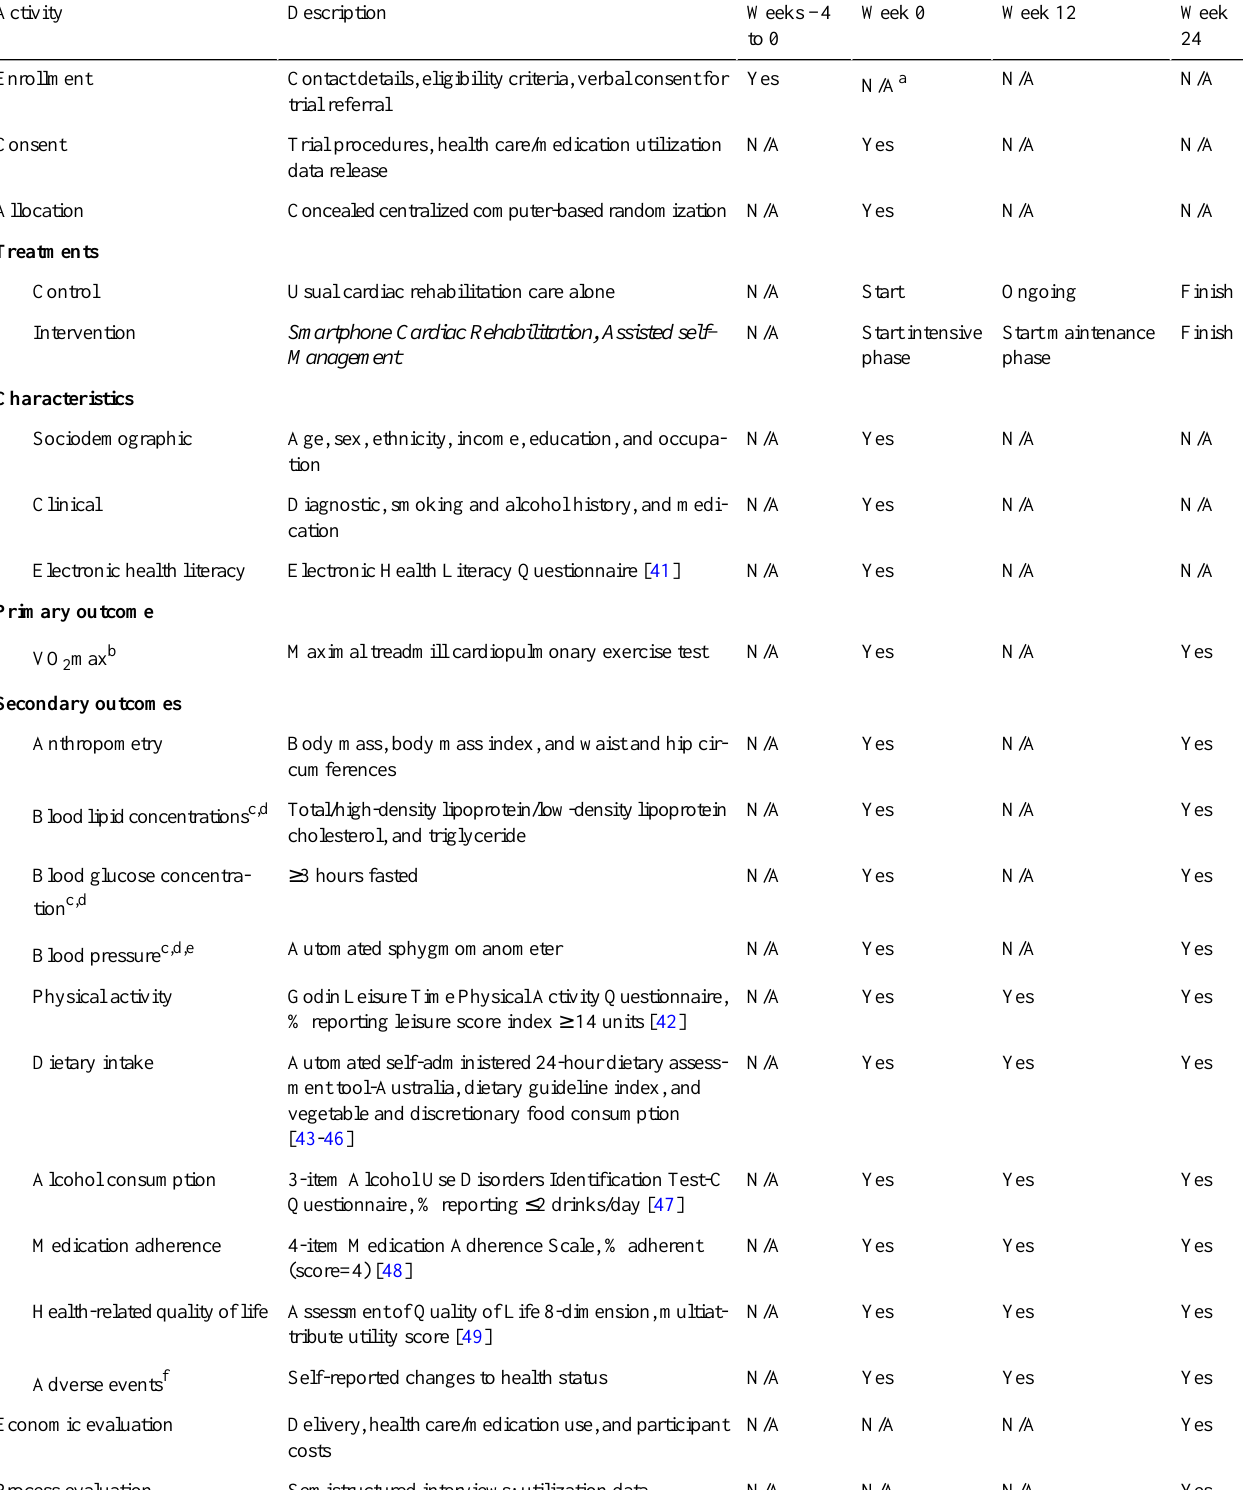
Table 3. Schedule of enrollment, treatments, and